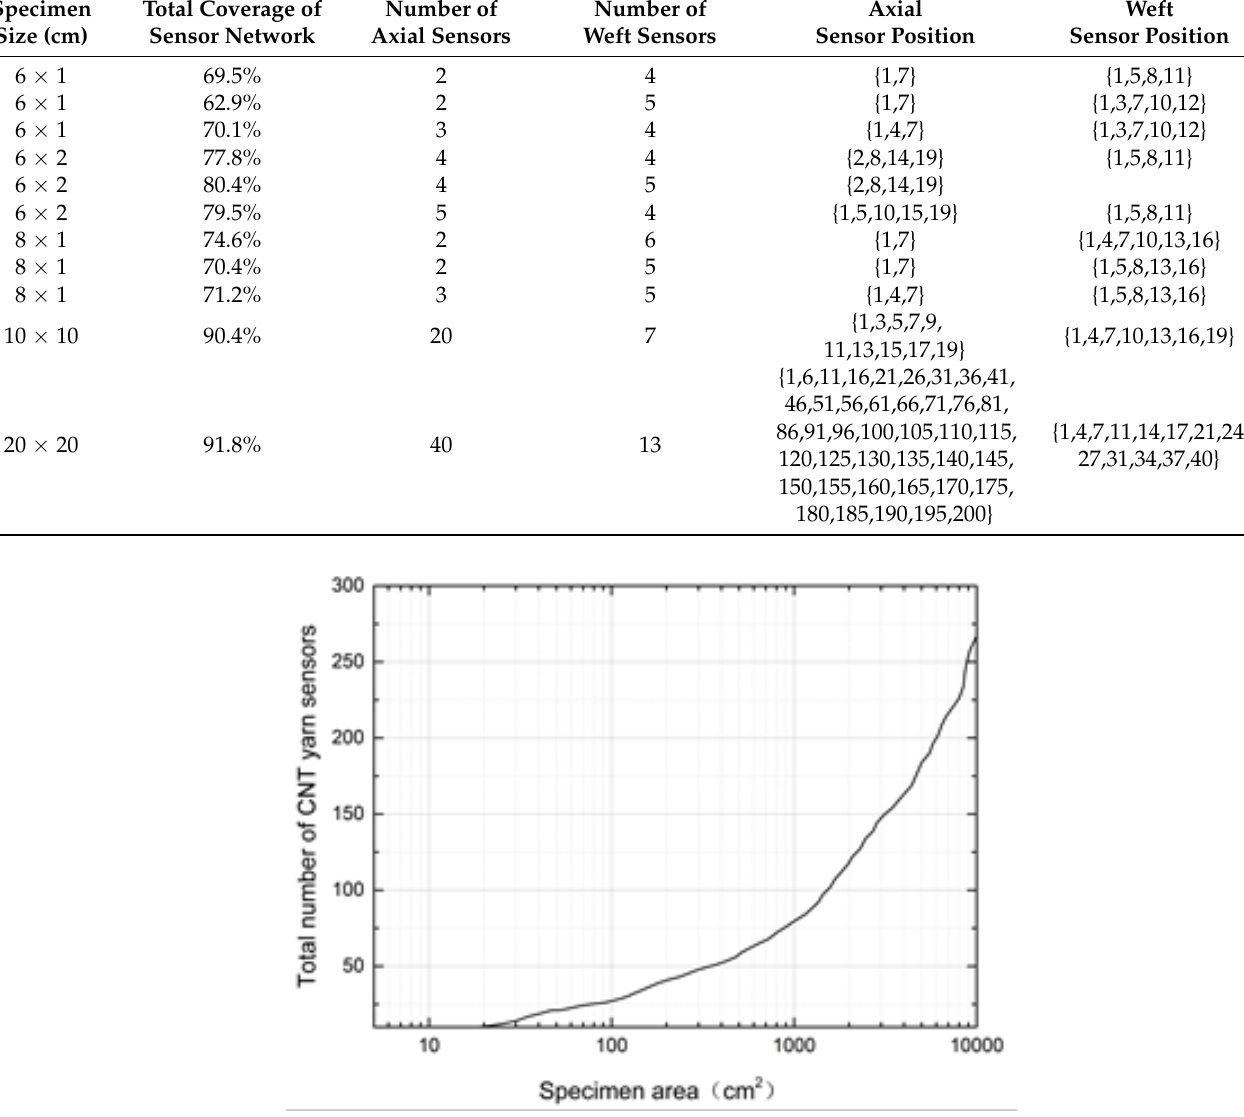
Figure 7. Relationship between the area of the specimen and the total number of optimized CNT yarn sensors. After optimizing the configuration of CNT yarn sensors embedded in braided composites using NNIA algorithm, the eigenvalues of the specimens were decomposed by the singular value decomposition method of quartered matrix. The damage coordinates of specimens 1 to 4 were calculated by comparison with the characteristic values of specimen 5 without damage. The actual damage coordinates of specimens (specimens 1 to 4) were obtained by ultrasonic C-scan technology. The comparison between the calculated coordinates and the actually measured coordinates is shown in Table 5. The results showed that the maximum deviation between the predicted coordinates and the actual measured coordinates was less than 1 mm. This showed that the CNT yarn sensor embedded in the optimized configuration scheme can basically realize the accurate location of the damage of the three-dimensional braided